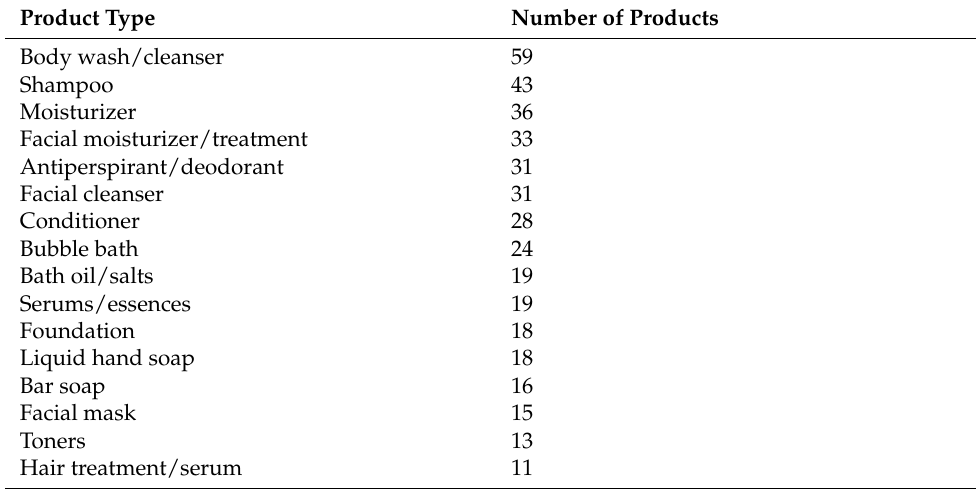
Table 6. Summary of products containing Lavandula Hybrida Oil (INCI) based on EWG data (US market